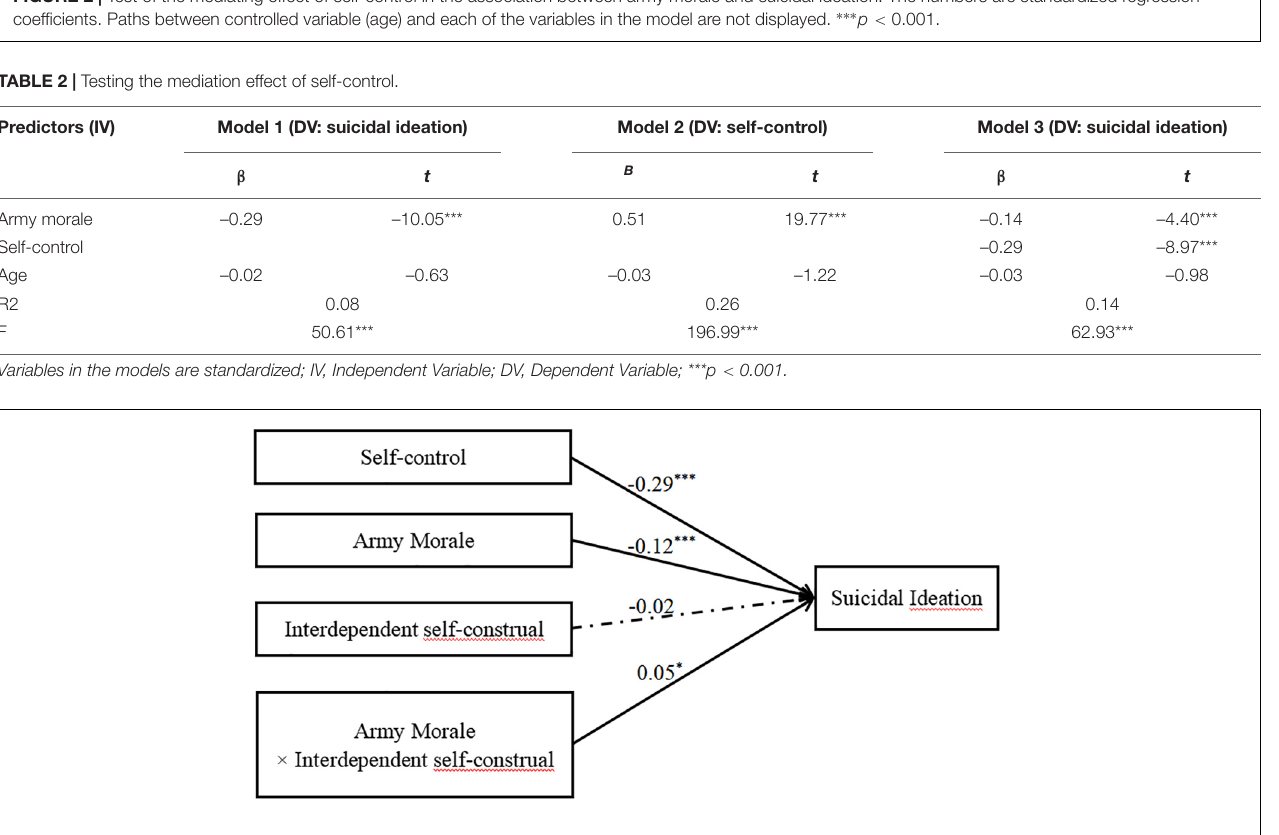
FIGURE 3 | Test of the moderating effect of interdependent self-construal on the association between army morale and suicidal ideation. The numbers are standardized regression coefficients. The dotted line indicates a non-significant relationship. Paths between controlled variables (age) and each of the variables in the models are not displayed. ∗ p < 0.05, ∗∗∗ p < 0.001.